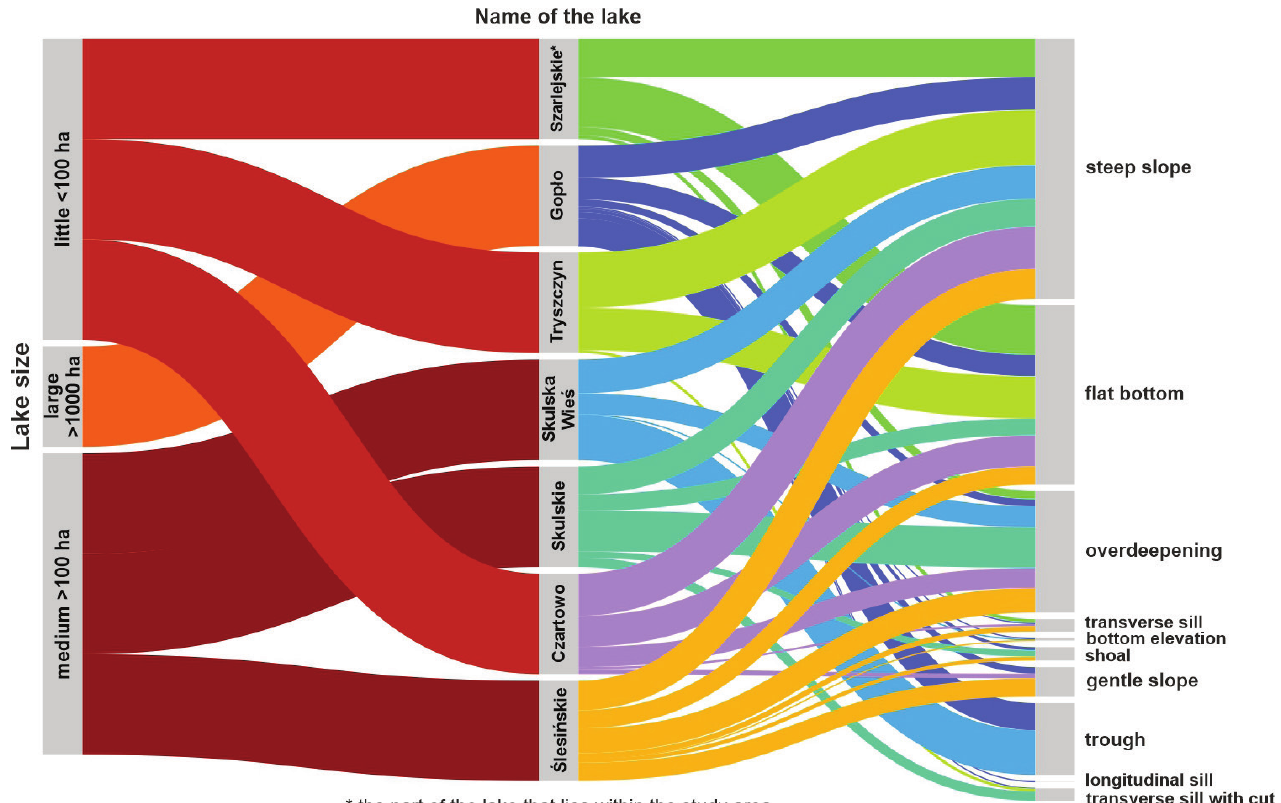
Figure 7. Division of the examined lakes by size and percentage share of individual subaqueous relief